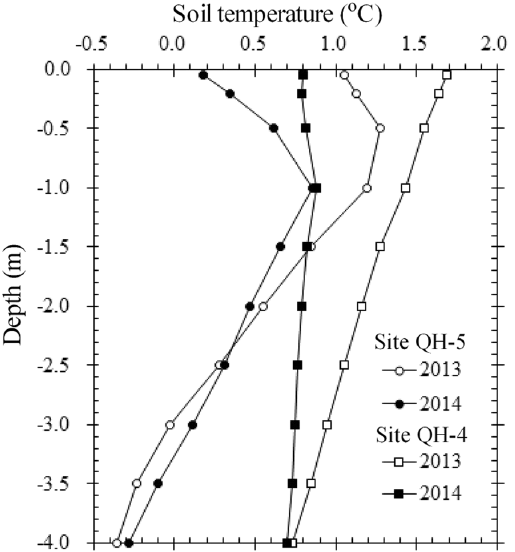
Figure 3. Mean annual soil temperature in 2013 and 2014 at 0.1 to 4.0 m depths at sites QH-4 (30 cm sand layer) and QH-5 (115 cm sand layer) in the Honglianghe River